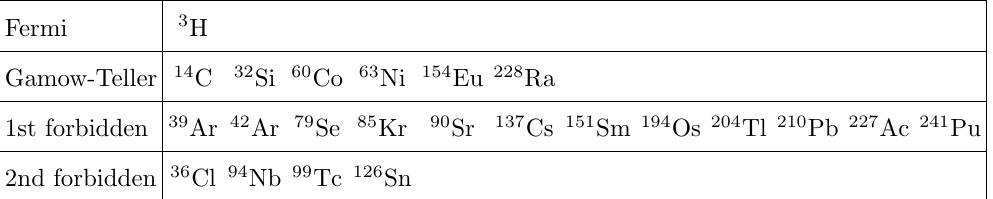
Table 2 . Every isotope which dominantly (cid:12) (cid:0) decays and has a half-life between 10 8 and 10 13 seconds, categorized by their main transition [104]. Only Fermi and Gamow-Teller transitions are not momentum-suppressed for our charged current operators and therefore of interest to